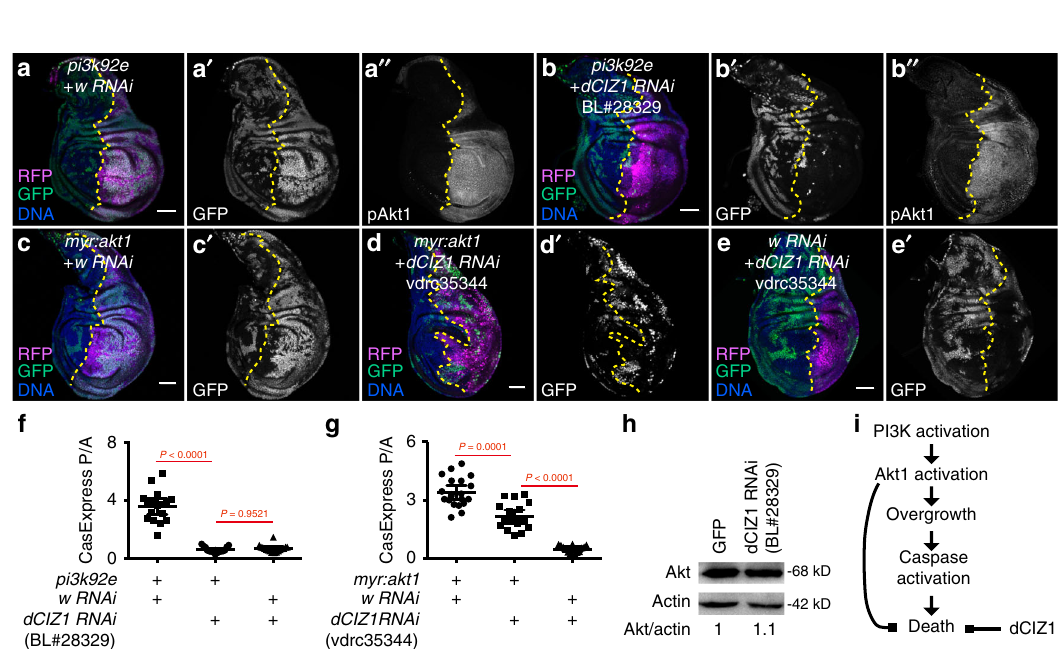
Fig. 7 dCIZ1 promotes survival from executioner caspase activation in PI3K- or Akt1-activated tissues. ( a , b ) Knocking down dCIZ1 suppressed CasExpress activation but not Akt1 activation in the compartment expressing pi3k92e . dCIZ1 RNAi (BL#28329) was used in ( b ). ( c – e ) Knocking down dCIZ1 suppressed myr:akt1 -induced CasExpress activation. dCIZ1 RNAi (vdrc35344) was used in ( c – e ), and Gal80 ts was used to limit expression of the transgenes to 3 days. ( f ) Quanti fi cation of CasExpress P/A in discs expressing L-CasExpress , L-trace , en-Gal4 , UAS-RFP , together with UAS-pi3k92e and UAS-w RNAi ( n = 17), or UAS-pi3k92e and UAS-dCIZ1 RNAi (BL#28329) ( n = 15), or UAS-dCIZ1 RNAi (BL#28329) and UAS-w RNAi ( n = 18). ( g ) Quanti fi cation of CasExpress P/A in discs expressing L-CasExpress , L-trace , en-Gal4 , UAS-RFP , tubGal80 ts together with UAS-myr:akt1 and UAS-w RNAi ( n = 20), or